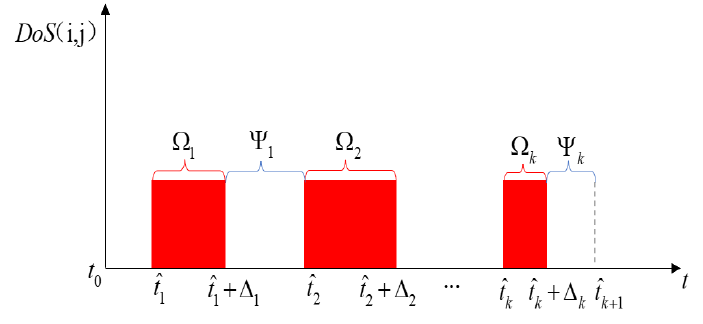
Figure 1. DoS attack